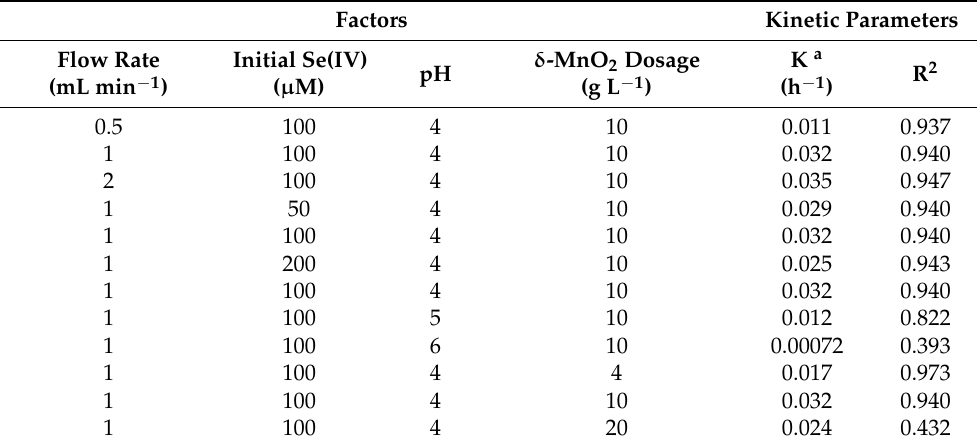
Table 2. The fitting kinetic parameters of Se(IV) oxidation by δ -MnO 2 influenced by solution pH, flow rates, initial concentrations, and mineral dosages under stirred-flow